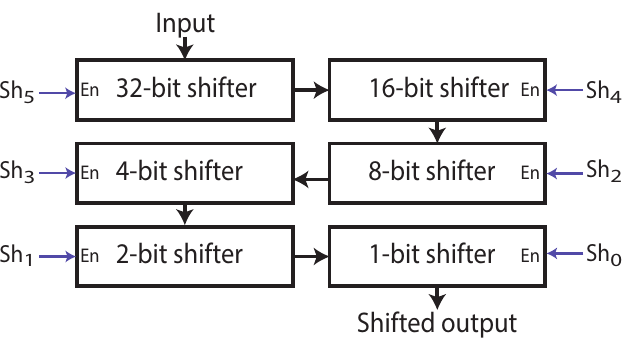
Figure 6. Barrel shifter used to align the operand